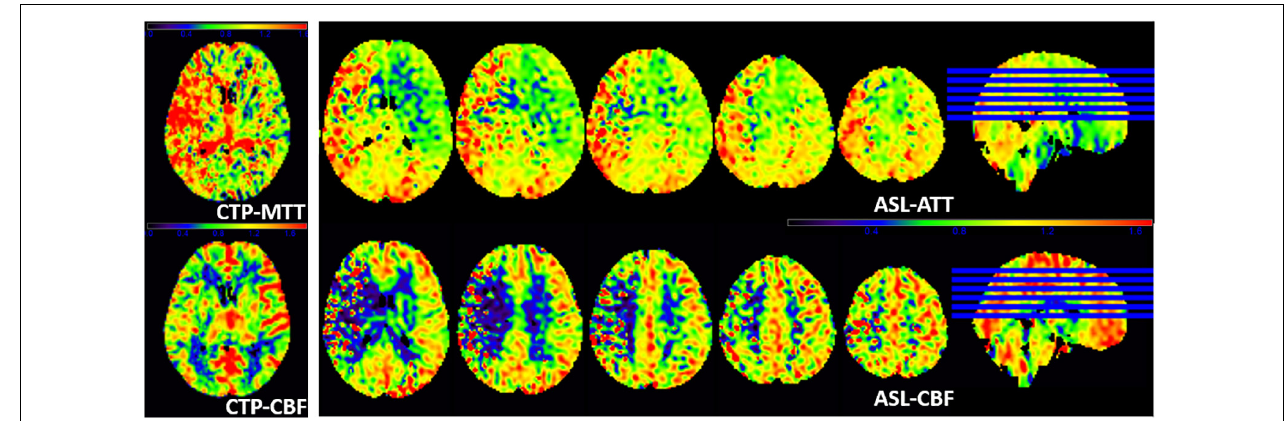
FIGURE 4 | A patient with left limb weakness for 9 days at admission. ASL-ATT, CTP-MTT, ASL-CBF, and CTP-CBF are normalized images and presented consistent results. CTP shows decreased CTP-CBF and increased CTP-MTT in the right frontal, temporal and occipital lobes; ASL shows decreased ASL-CBF and increased ASL-ATT of the right frontal, temporal and occipital lobes compare with the contralateral side. However, ASL-CBF shows focal intravascular signals and low tissue perfusion in the right frontal, temporal and occipital lobes, which may indicate the status of collateral perfusion.